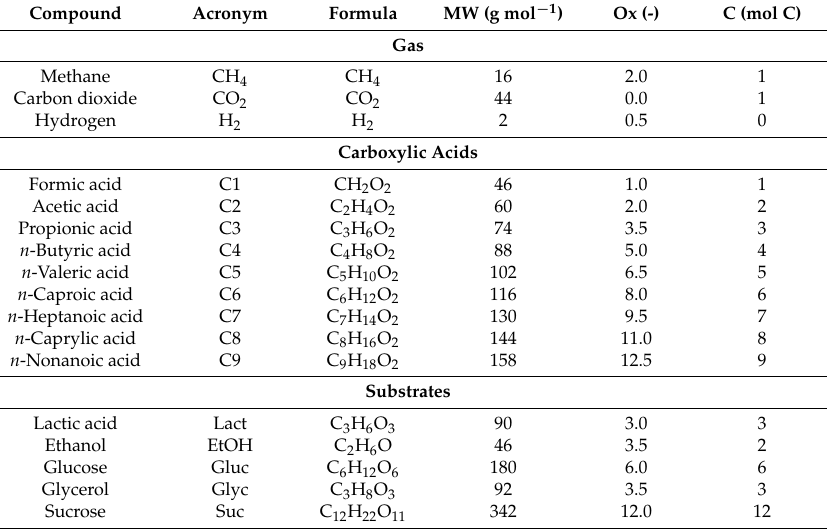
Table A1. Conversion constants used to convert reported values to corresponding COD content.